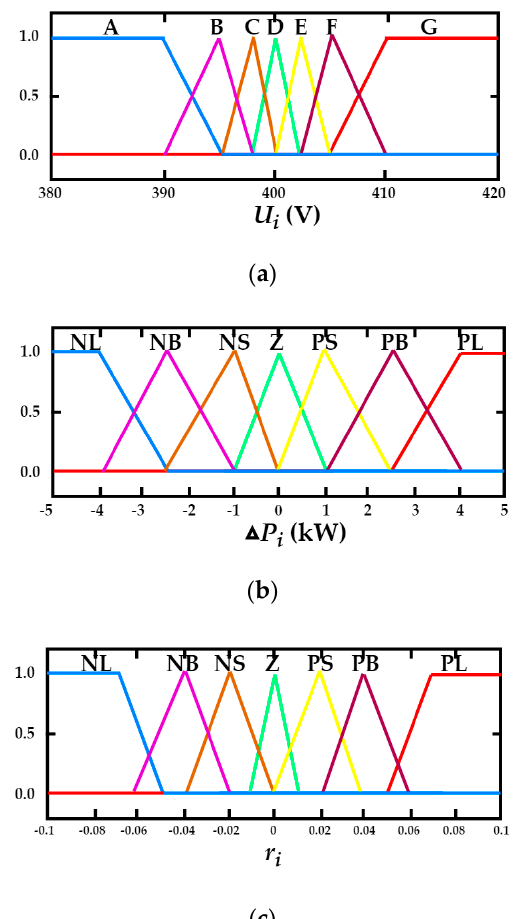
Figure 6. The membership function. ( a ) Voltage membership function; ( b ) power difference membership function; ( c ) output membership function.